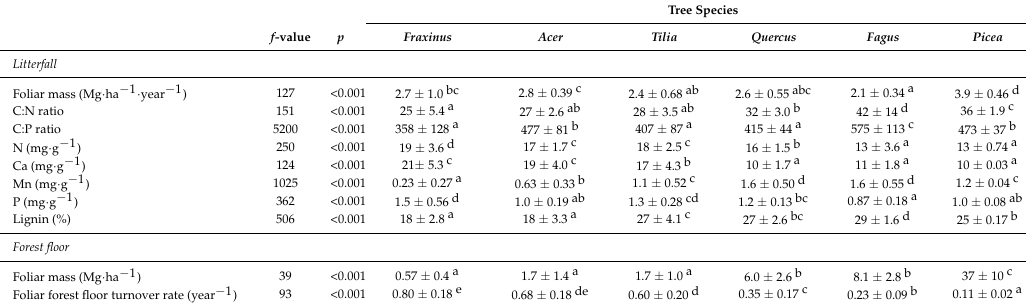
Table 2. Mean and standard deviation of annual litterfall, foliar litter quality and forest floor accumulation for the tree species across all six common gardens. Significant differences between tree species are indicated with letters, means with the same letter are not significantly different (Tukey post-hoc tests on LME models, 1|Site). Litterfall and forest floor foliar mass and nutrient concentrations in litter were previously published by Vesterdal et al. [35,36].